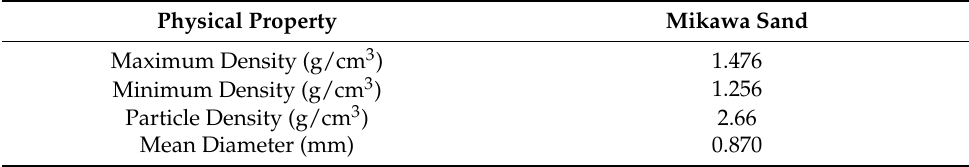
Table 2. Physical properties of “Mikawa” sand used in this study.